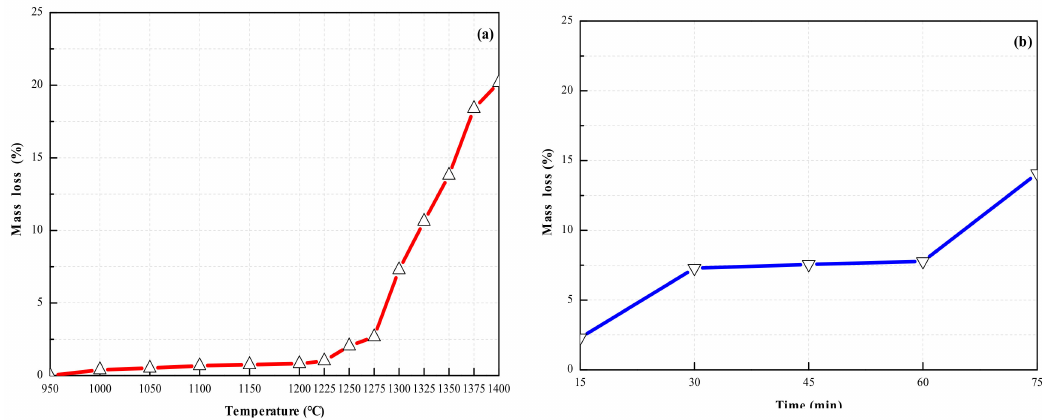
Figure 2. Mass loss of PCDS ( a ) at di ff erent calcination temperatures; ( b ) for di ff erent calcination